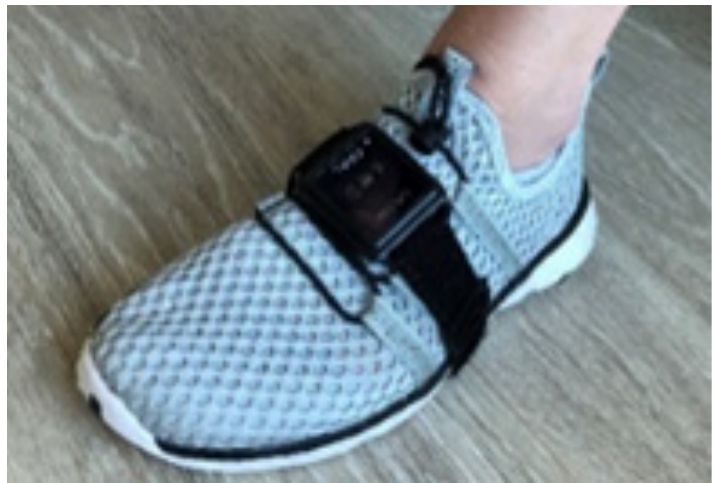
Figure 1. Inertial sensor (Opal) placement on the foot dorsum.